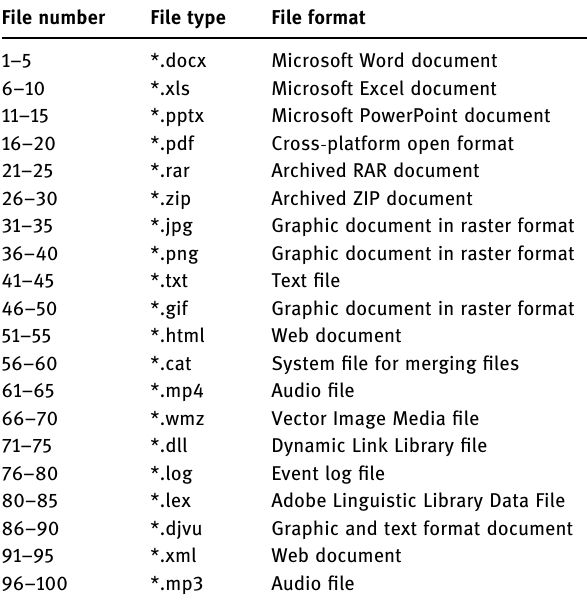
Table 7: Plaintext fi les used in testing the LBC - 3